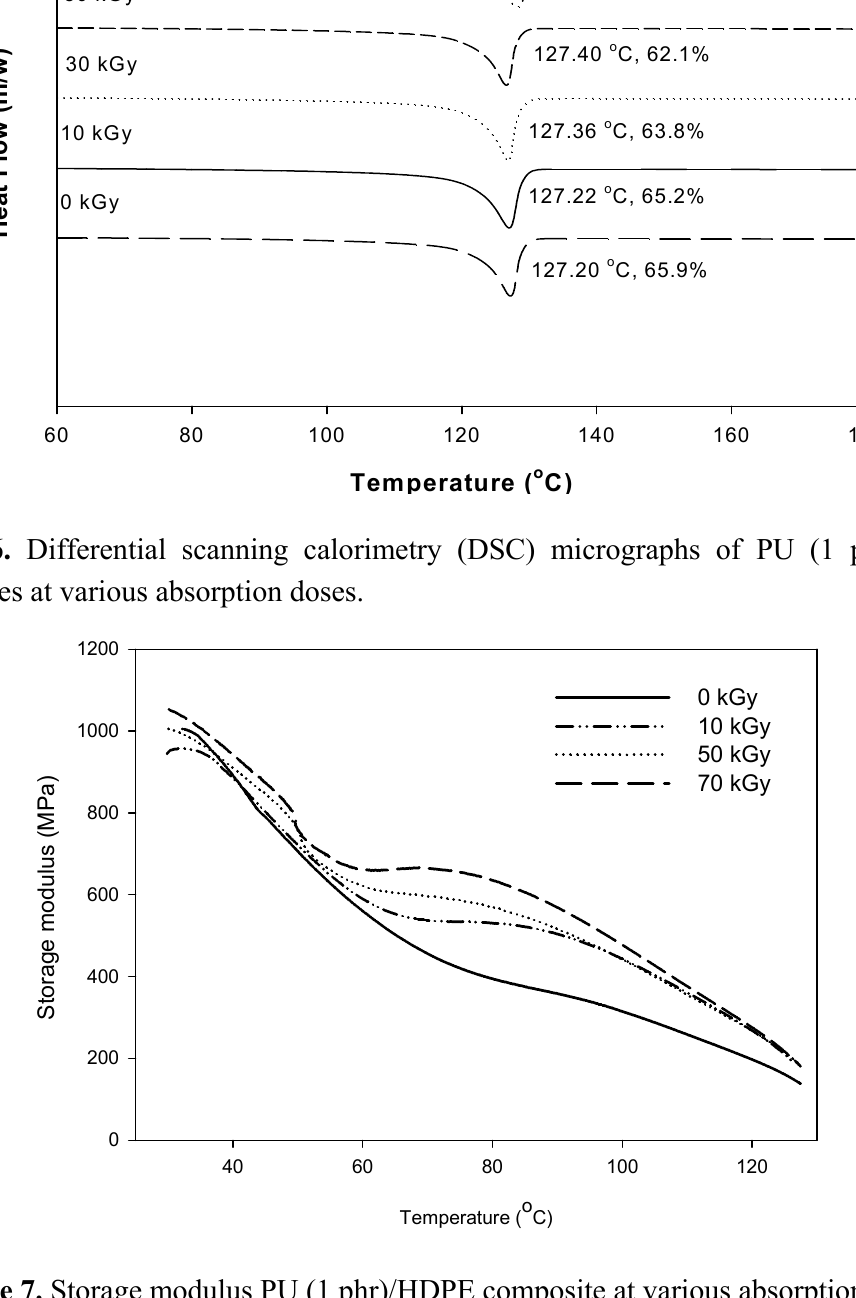
Figure 7. Storage modulus PU (1 phr)/HDPE composite at various absorption